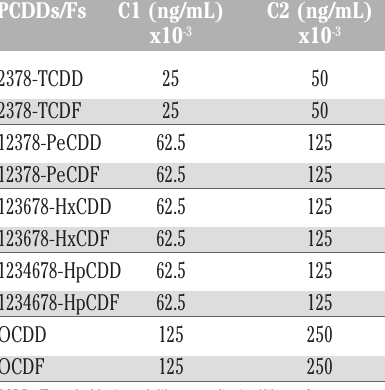
Table 2. Polychlorinated dibenzo -p- diox- ins/dibenzofurans concentrations used for dose-response curves: test in vitro .